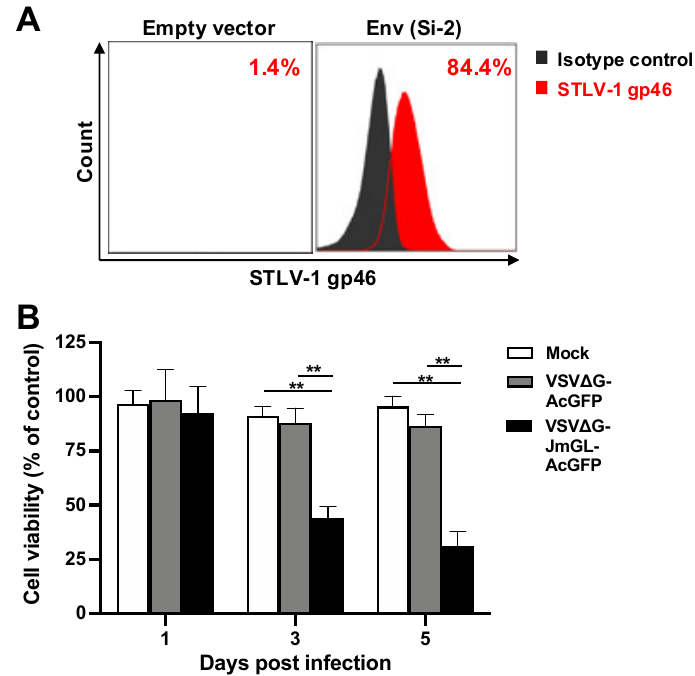
Figure 4. Reduction of STLV-1 Env-expressing target cells by infection with rVSV. ( A ) The expression level of STLV-1 Env by Lenti-X 293T cells was analyzed at 24 h after their transfection with an empty vector as a control or STLV-1 Env (Si-2 strain) expression plasmid. These cells were stained with anti-HTLV-1 gp46 MAb or mouse IgG1 MAb as an isotype control and then subjected to flow cytometry. The percentages of STLV-1 gp46-positive cells are presented in each panel. ( B ) Results from an evaluation of the rVSV-mediated killing effects on STLV-1-Env expressing cells are shown. The cells described in ( A ) were mock-infected or infected with G-complemented VSV ∆ G-AcGFP or VSV ∆ G-JmGL-AcGFP at an MOI of 1. The numbers of viable cells were counted on days 1, 3, and 5 after infection, and the cell viabilities (% of control) of each group of rVSV-infected Si-2-Env- expressing cells relative to each group of virus-inoculated control cells were calculated. Data obtained from five independent experiments are expressed as the mean ± SD. Asterisks in panel ( B ) represent significant differences versus mock- or VSV ∆ G-AcGFP-infected cells (** p < 0.001 significance, by two-tailed Student’s t -test with equal